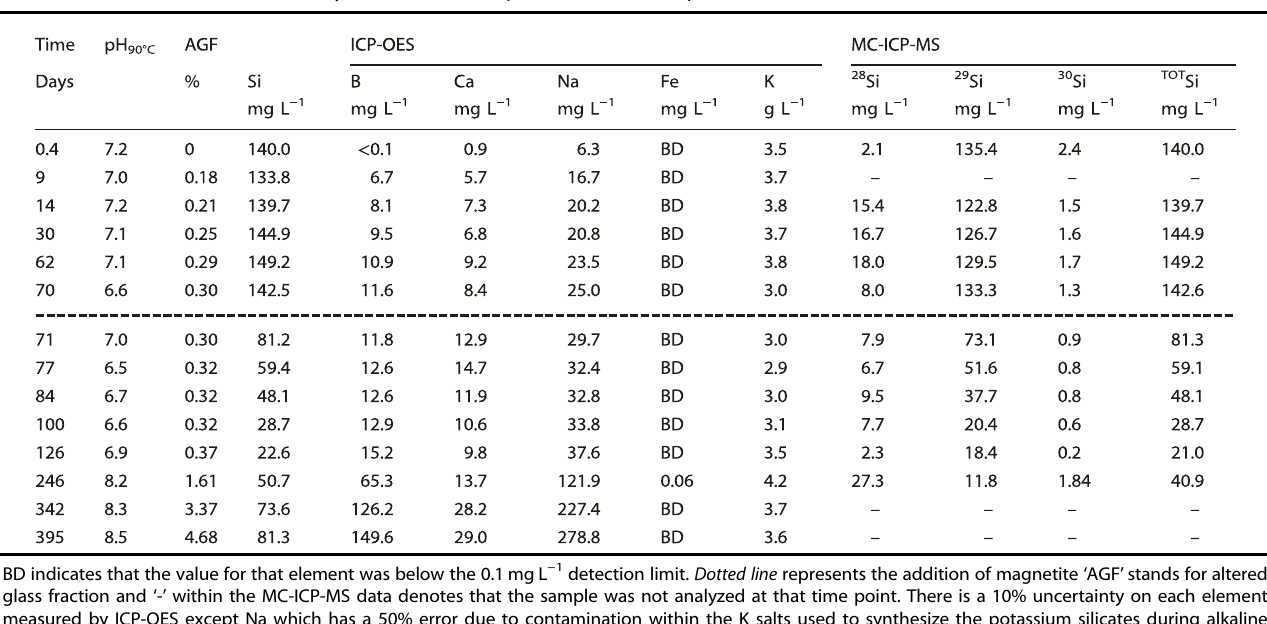
Table 1. ICP-OES and MC-ICP-MS analysis of solution sampled at various time points